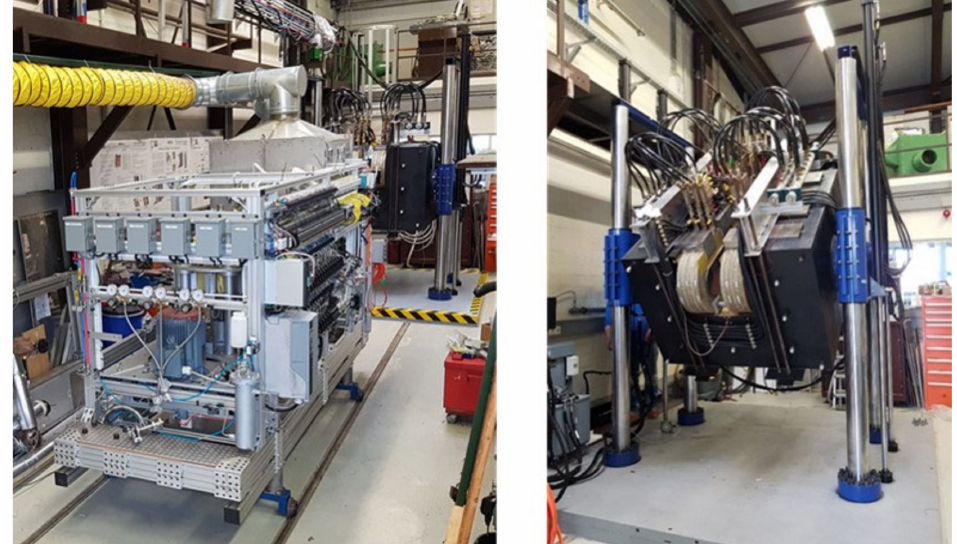
Figure 8. MaPLE PbLi loop and magnet during installation at